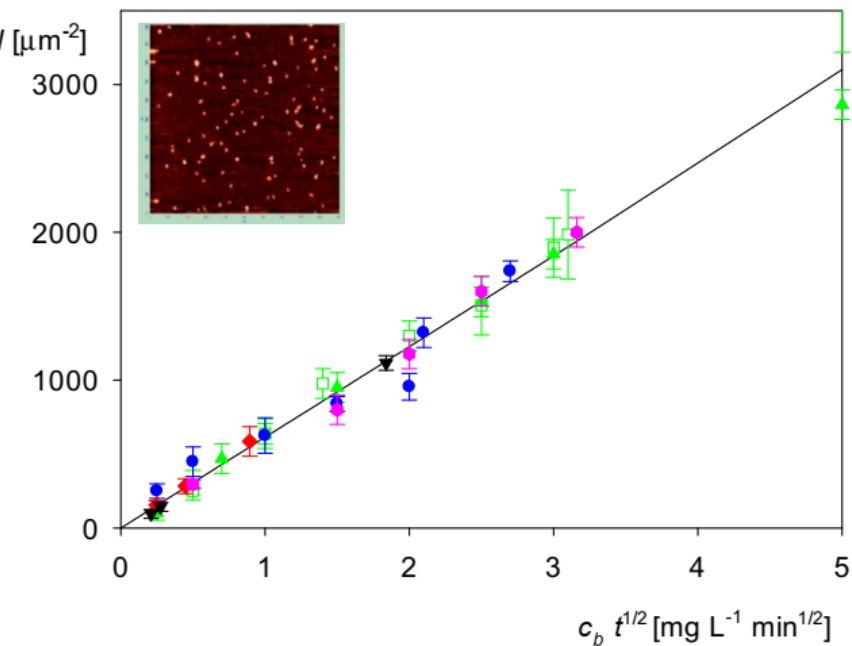
Figure 4. Dependence of the surface concentration of HSA, N [ µ m − 2 ] on the c b t 1 / 2 [mg L − 1 min 1 / 2 ] parameter. The points denote experimental results obtained by a direct AFM enumeration of adsorbed HSA molecules at pH 3.5, I = 0.15 and 0.01 M and c b range 0.2 to 1 mg L − 1 . The inset shows the AFM image of the HSA layer on